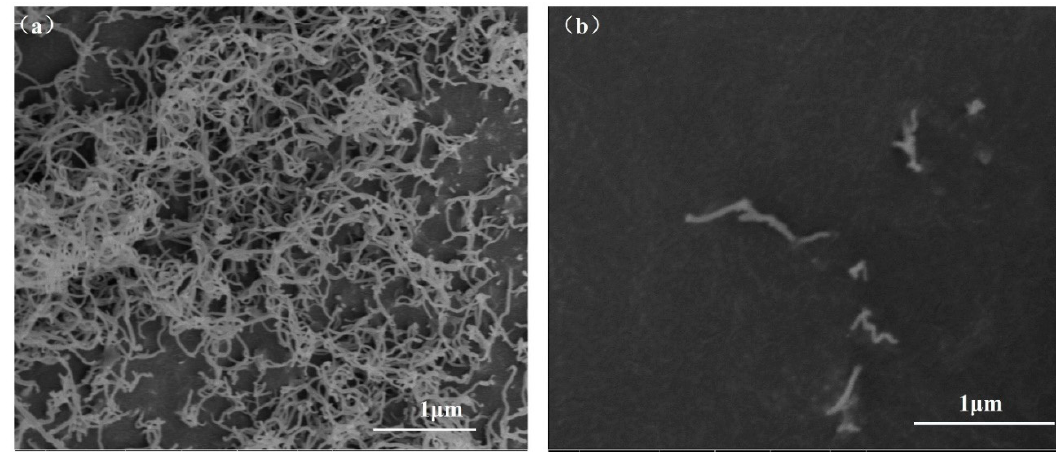
Figure 2. SEM of CNTs: ( a ) before dispersion; ( b ) after dispersion.